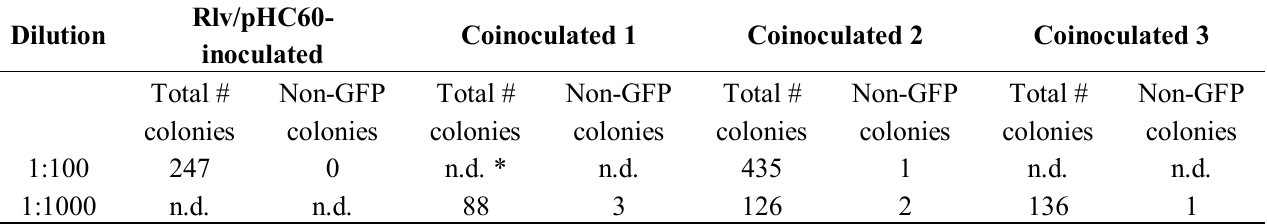
2. Recovery of bacteria from nodules of Rhizobium leguminosarum bv. viciae -inoculated and coinoculated